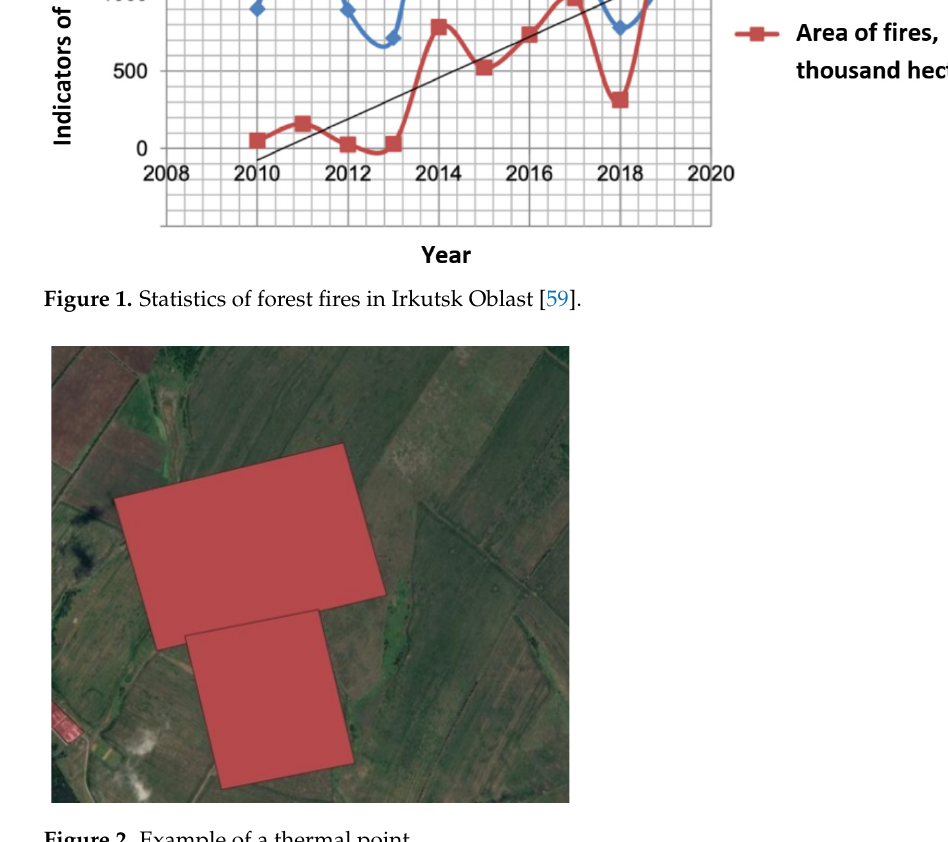
Figure 1. Statistics of forest fires in Irkutsk Oblast [59].